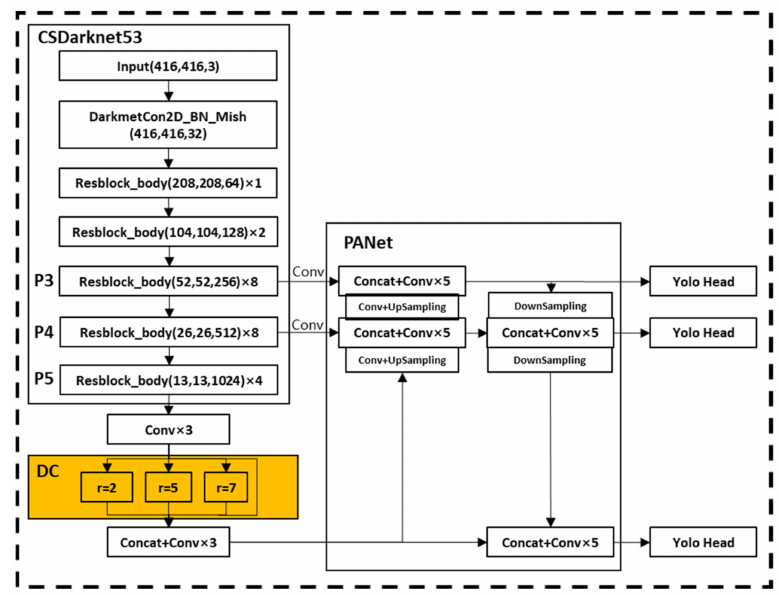
Figure 4. Improved network structure through the dilated